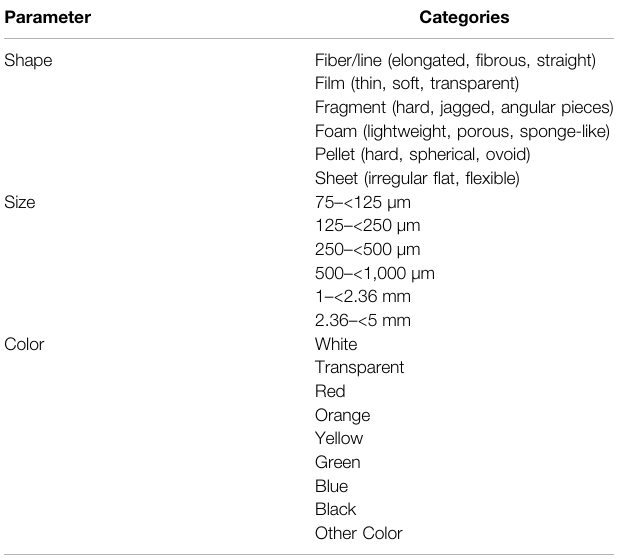
TABLE 2 | Classi fi cation and categorization used for the collected